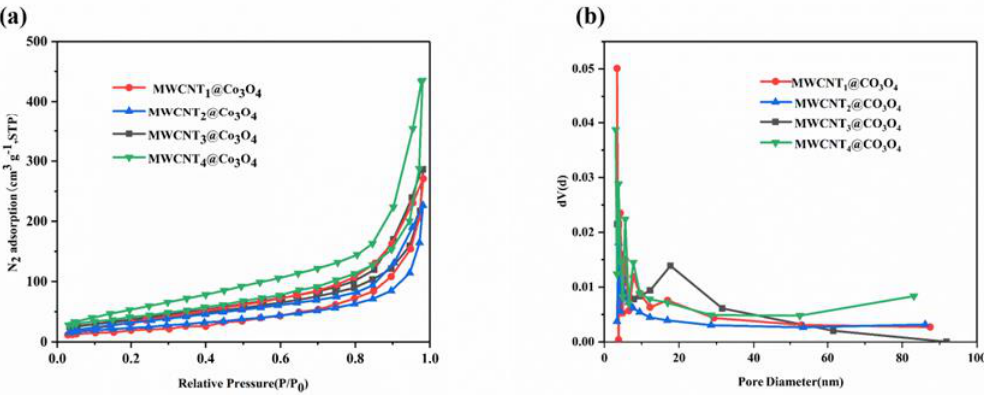
Figure 6. MWCNTx@Co 3 O 4 composites ( a ) N 2 adsorption desorption isotherm and ( b ) pore size distribution line.